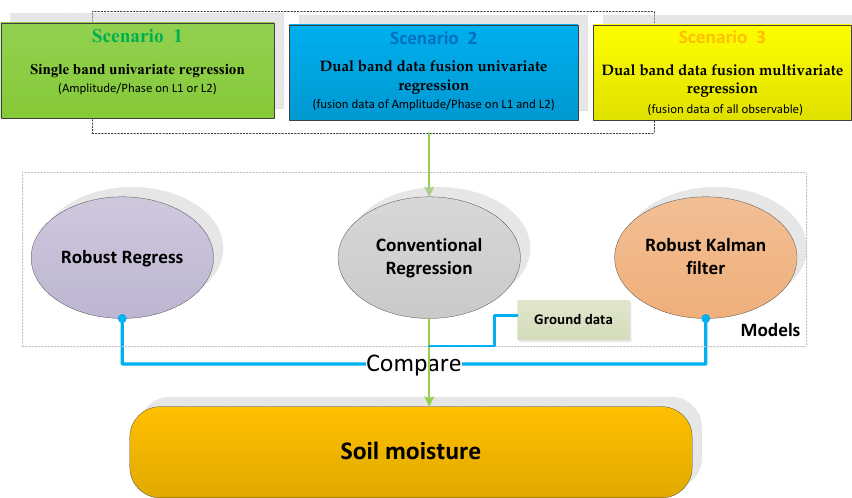
Figure 2. Lamasquère Experiment location: ( a ) map of France with a black box locating the region surrounding Lamasquère; ( b ) zoom on the Lamaquère plots where the measurements were taken (yellow dot); ( c ) zoom on the installed instrumentation with 2 ML3 Theta probes and Leica GR25 receiver and AR10 antenna.